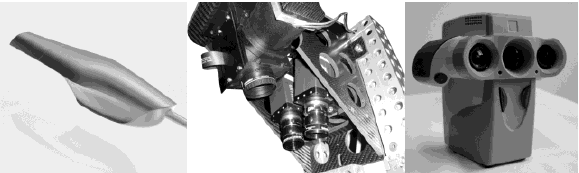
Figure 4: Scanning devices DS (schematic image - left), HS (middle), and CS (right)